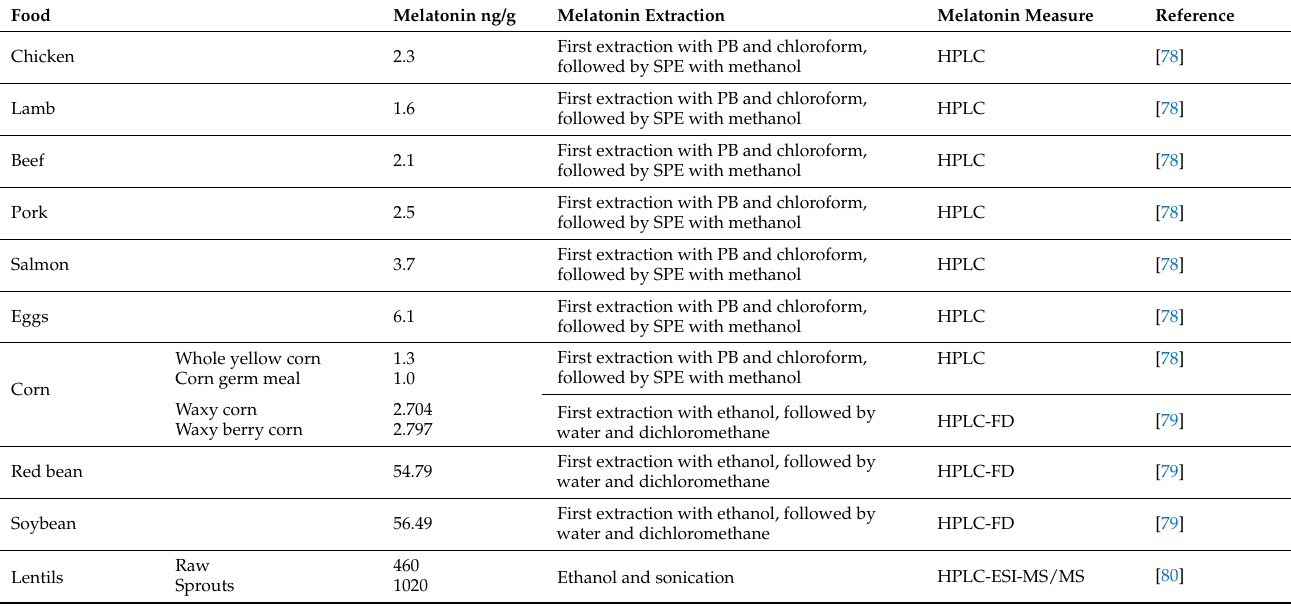
Table 4. Melatonin content in meat, fish, egg, and oils.